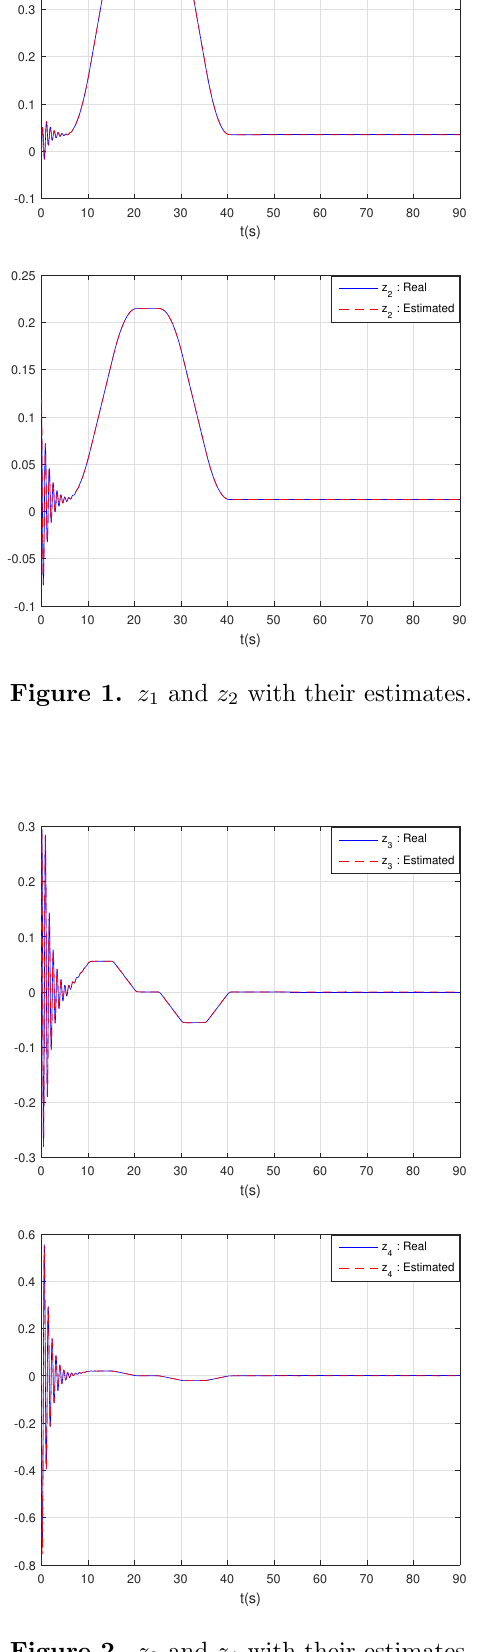
Figure 2. z 3 and z 4 with their estimates.